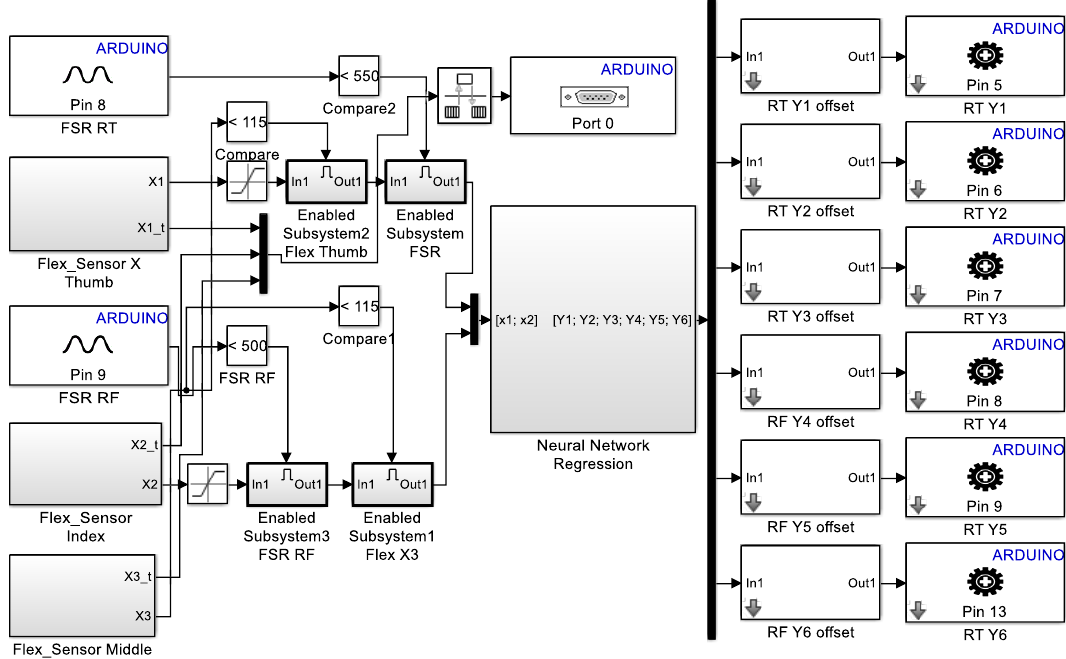
Figure 8. Overall embedded grasp posture control blocks for extra robotic fingers.